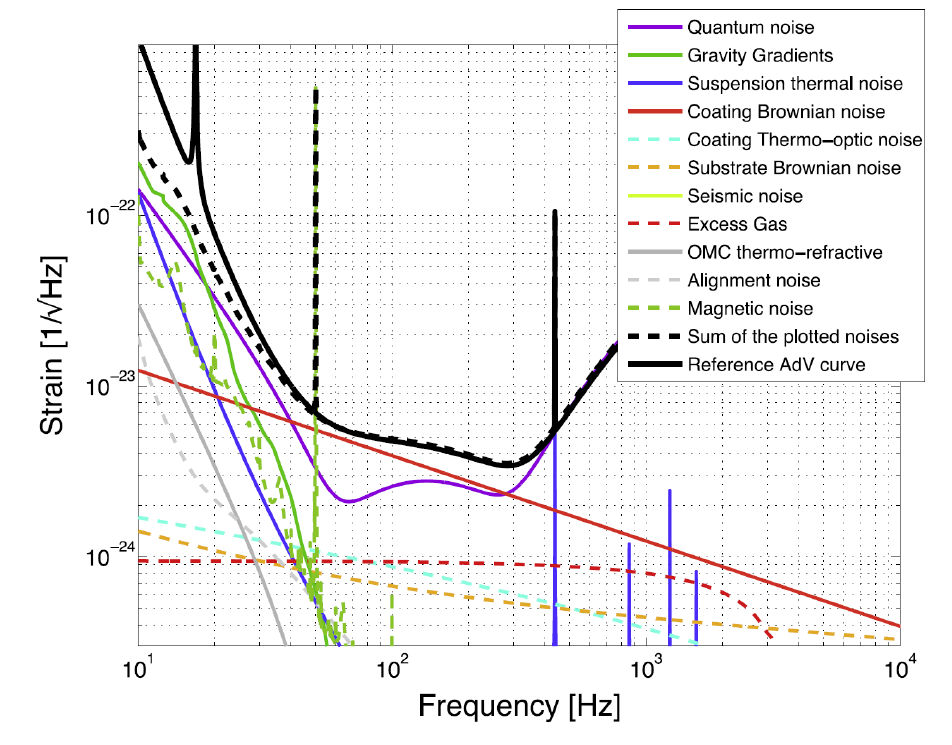
Figure 3. The noise (dashed black lines) computed as the sum of all the known noise contributions, is compared to a reference AdV sensitivity (solid black line). The contributions from all the single noise sources are also shown. Figure taken from [90]: © The Authors, published by EDP Sciences. This is an open access article distributed under the terms of the Creative Commons Attribution License 4.0 (http://creativecommons.org/licenses/by/4.0/ (accessed on 10 August